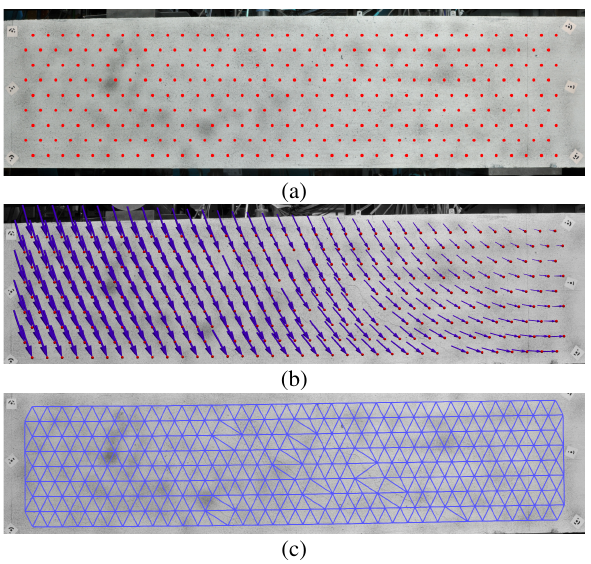
Figure 1. (a) Reference image with the points to be matched; (b) deformed state and displacement field (scale factor: 5, based on (Liebold et al., 2020a)); (c) mesh of the matching points tracked successfully. Based on (Liebold and Maas, 2018).